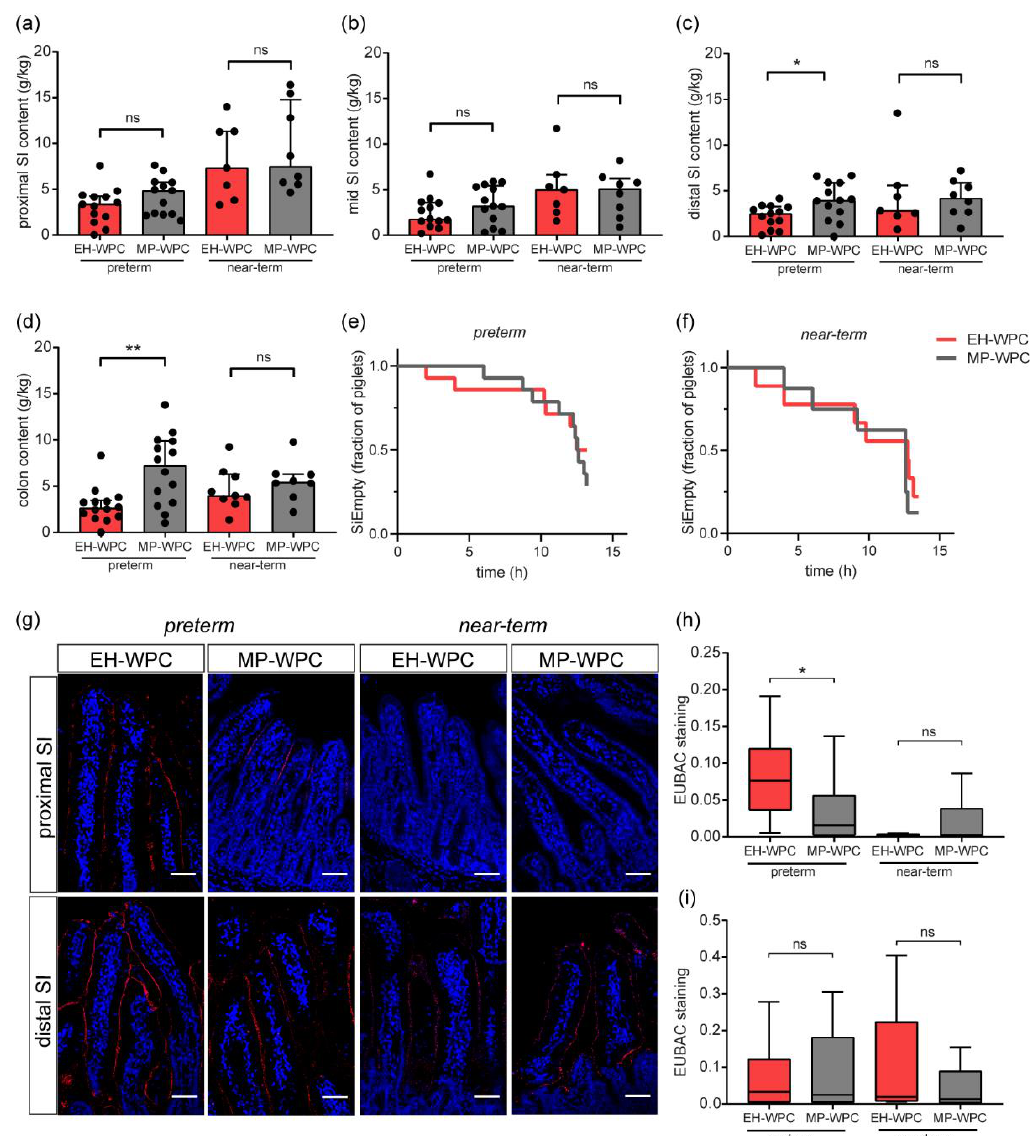
Figure 4. GI transit and mucosal bacterial adherence. ( a – d ) Weight of small intestine and colon content was determined at day 5 (g/kg bodyweight), 1 h after the last bolus of EN, in separated regions ( a ) proximal small intestine, ( b ) mid small intestine, ( c ) distal small intestine and ( d ) colon. ( e , f ) Fraction of piglets that not cleared the contrast fluid from the small intestine over time ( h ), determined by x-ray analysis, for ( e ) preterm and ( f ) near-term piglets. ( g ) Fluorescent in-situ hybridization (FISH) detection of eukaryotic bacteria in proximal and distal small intestinal tissue slides, with quantification of staining intensity in ( h ) proximal small intestine and ( i ) distal small intestine. n = 14 for preterm piglets, n = 8–9 for near-term piglets. white scale bar equals 50 µm. * p < 0.05, ** p < 0.01, ns = non-significant based on Mann–Whitney test between EH-WPC and MP-WPC. SI = small intestine, EUBAC = eubacteria.